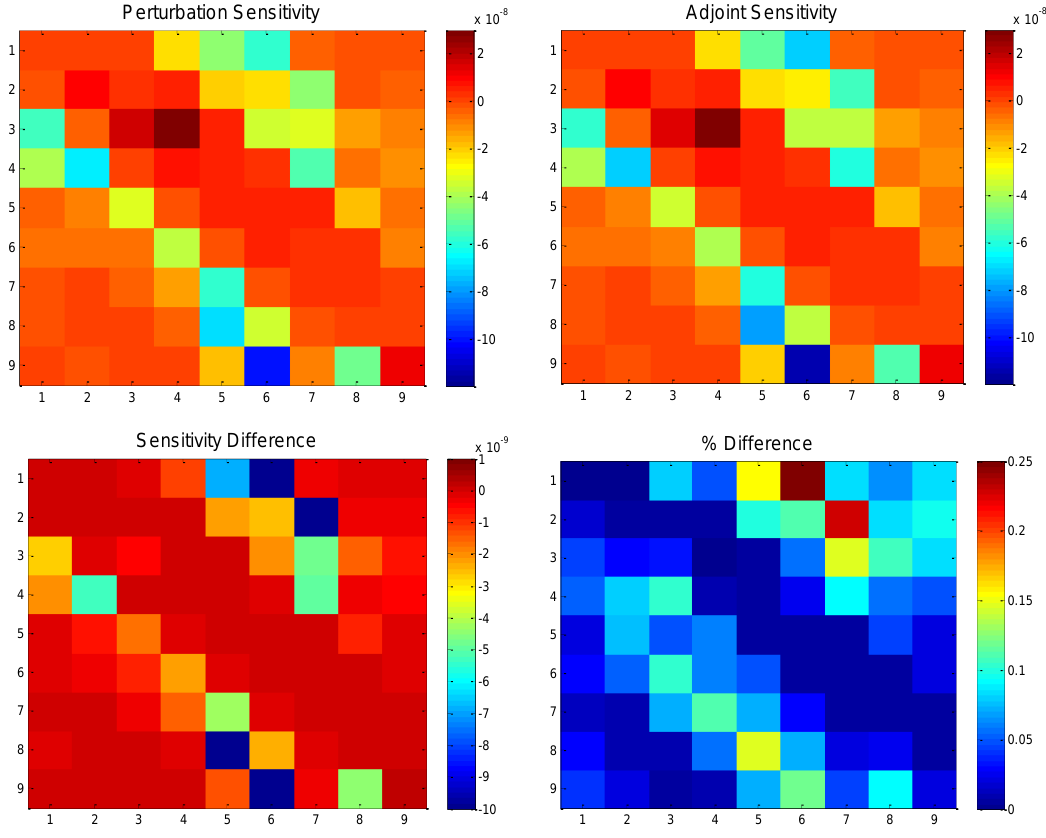
Figure 4—Sensitivity comparison of